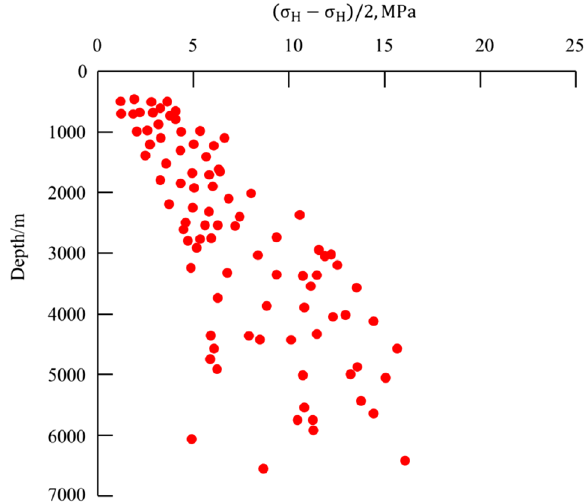
Fig. 11 Distribution of horizontal shear stress with depth in the northeastern of